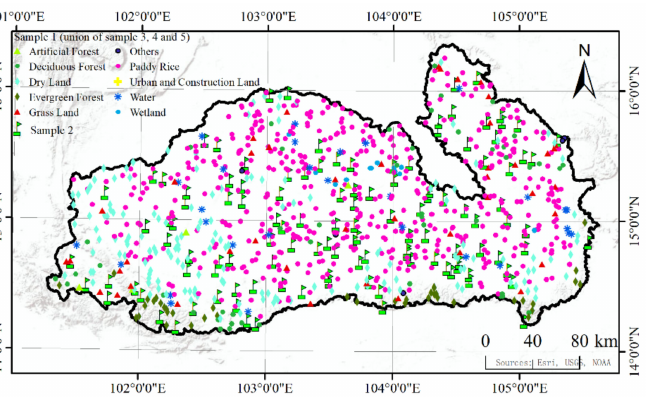
Figure 6. Distribution of samples. Group 1 is a union of groups 3, 4, and 5 and is shown in separate class symbols. Group 2 consists of selected pure-pixel points spread out over the map.